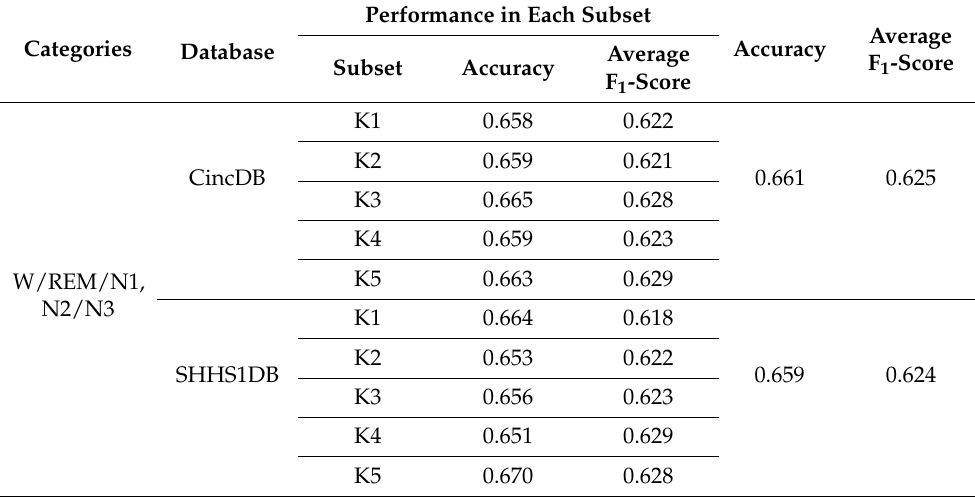
Table 5. Performance of sleep staging model.